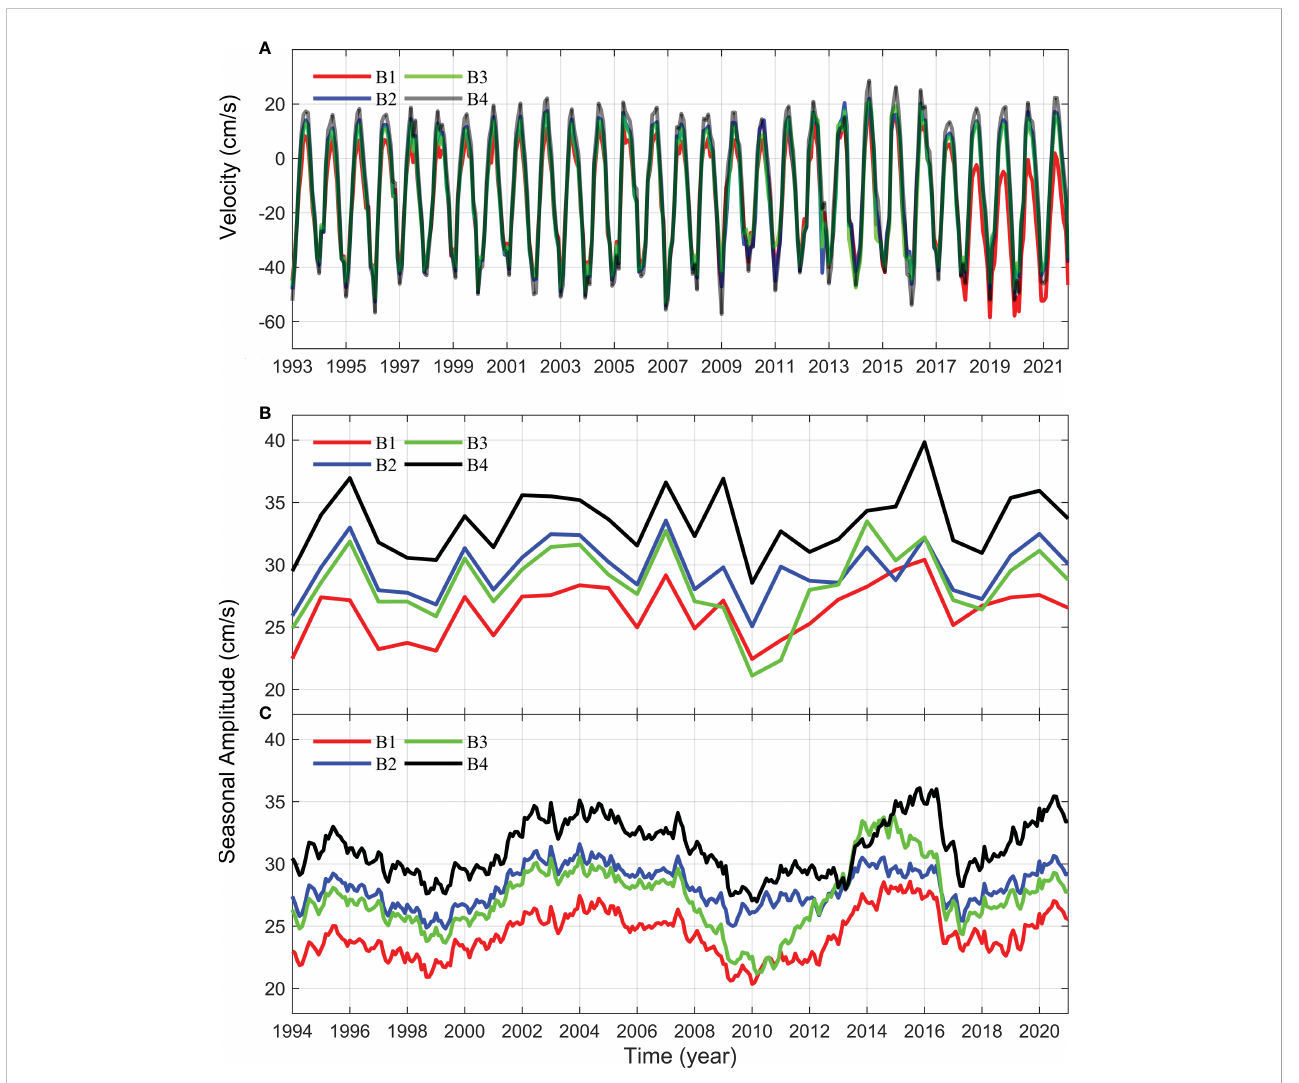
FIGURE 3 (A) Time series of vertically-averaged ASVs at four stations. (B) The seasonal amplitudes of vertical average ASVs obtained by the winter-summer difference algorithm (Method 1), (C) same as (B) but by the harmonic algorithm (Method